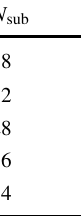
Table 4 Same as Table 3 for each process of Table 2. The number of data points in each process is given directly below the name of the process